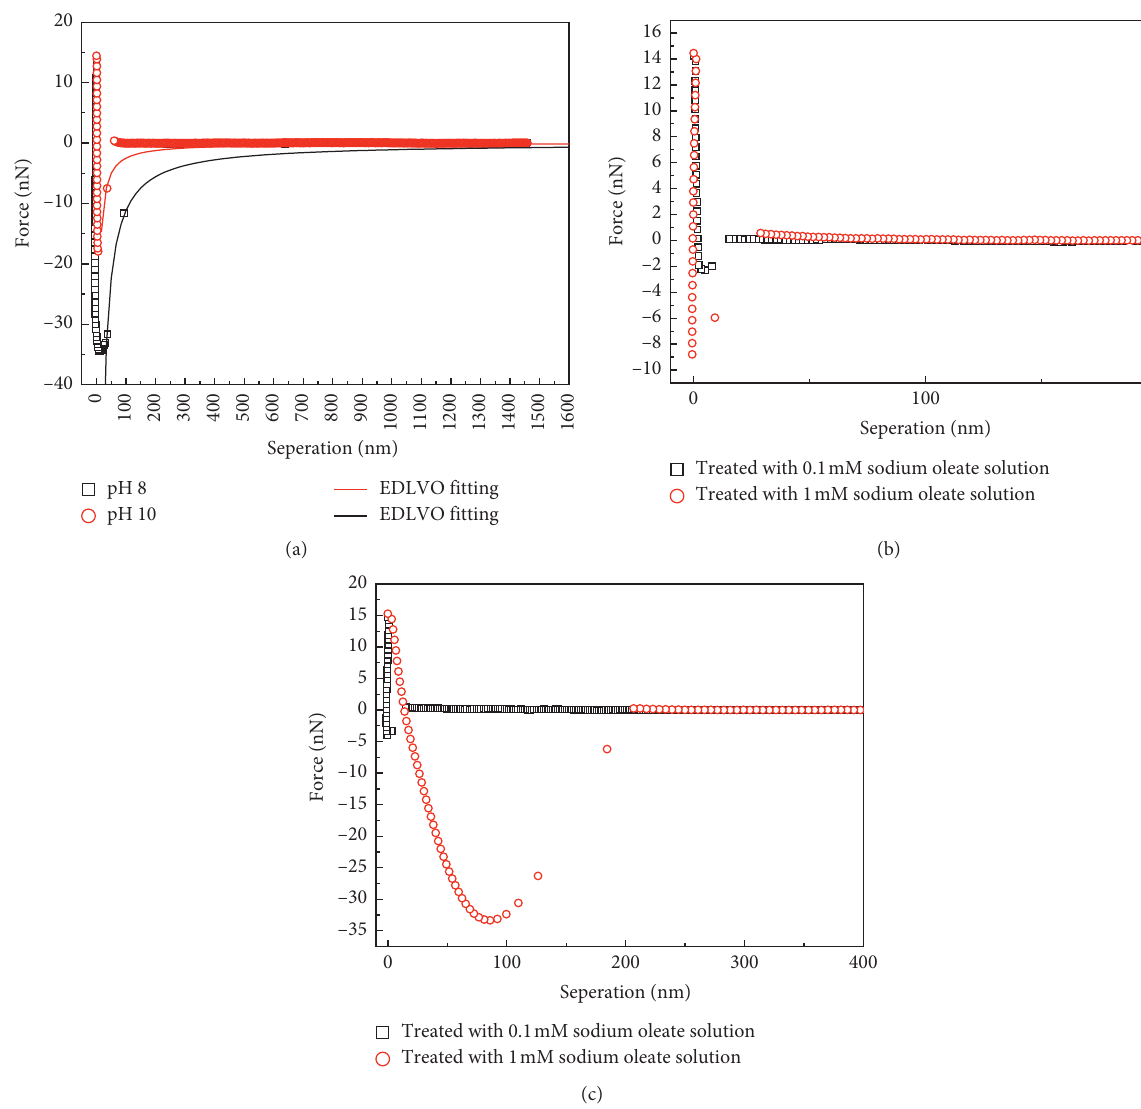
Figure 16: The approach curves in sodium oleate solution: (a) scheelite-scheelite in 0.1mM sodium oleate solution; (b) scheelite-fluorite; (c)